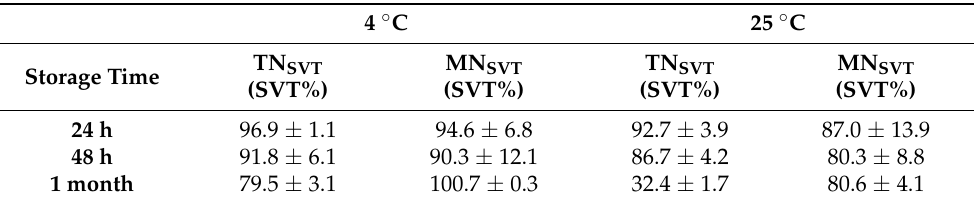
Table 2. Amount of encapsulated SVT (as % of initial SVT, concentration 1 mg/mL) in micelles after 24 h, 48 h and 1 month at 4 and 25 ◦